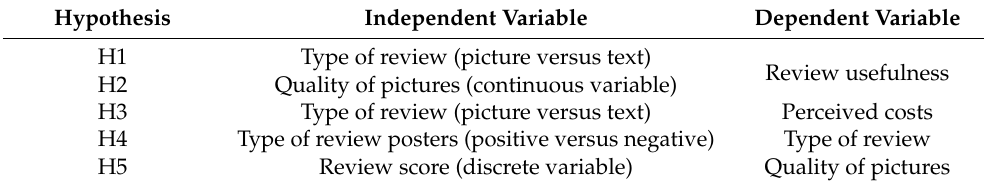
Table 1. Variables defined for each